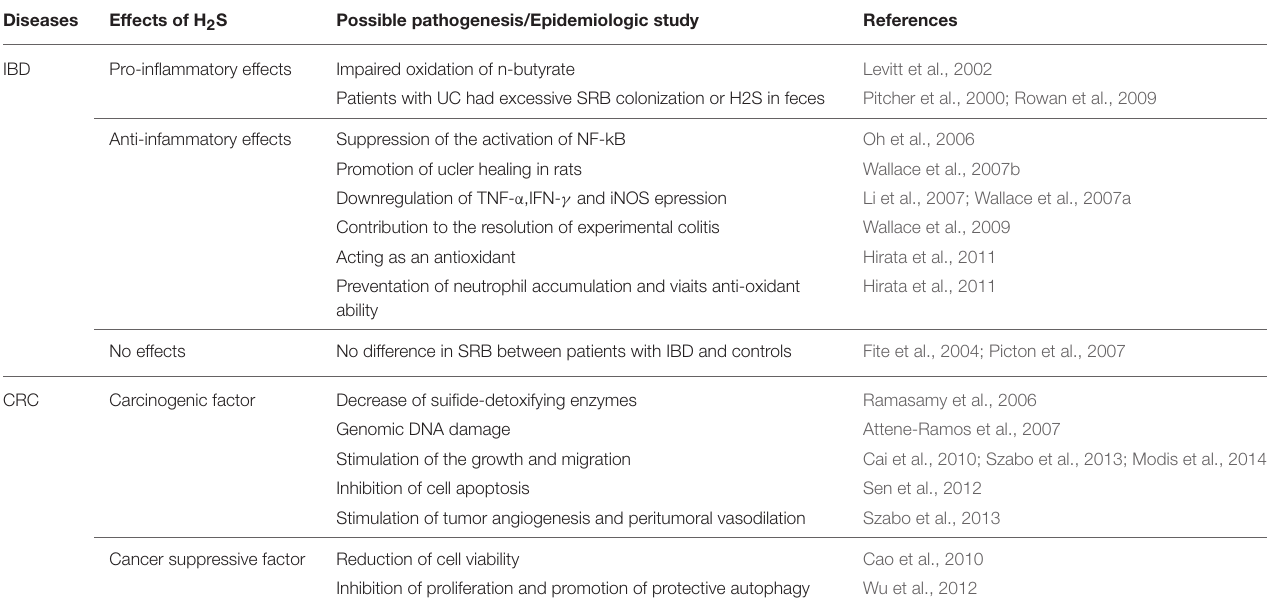
TABLE 1 | Roles of H 2 S in the pathophysiology of IBD and CRC.